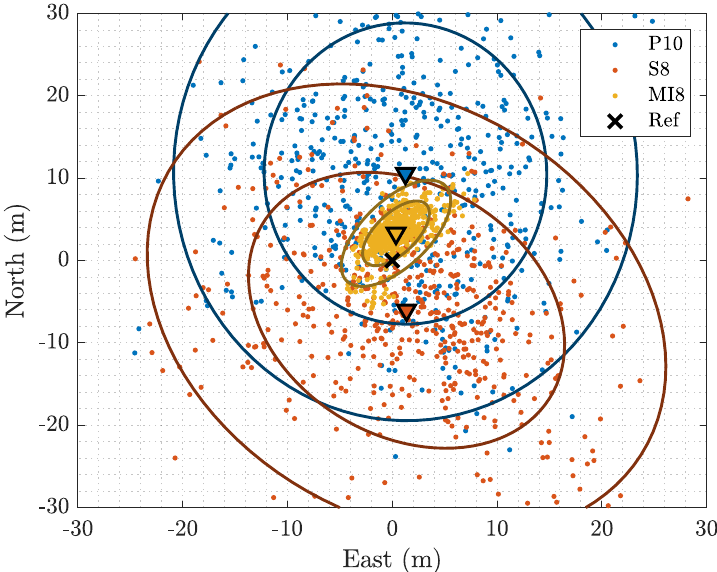
Figure 3. Comparison of the Position, Velocity, and Time (PVT) (Weighted Least-Squares) (WLS), as estimated by the three different devices, in a real environment. The true reference position is shown at the top, along with the average, the 1- σ , and the 2- σ ellipses for all the three